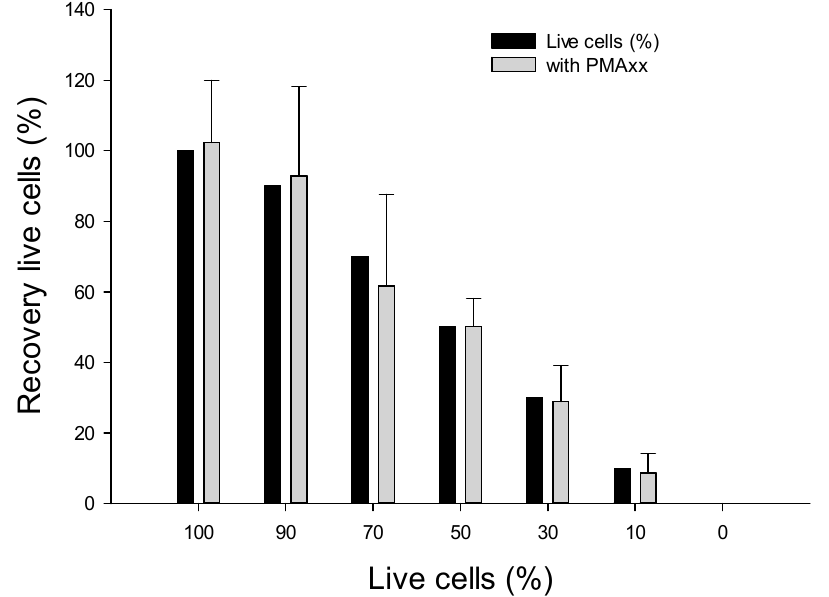
Figure 3. Effectiveness of PMAxx in selectively amplifying DNA from viable cells, mixtures of viable and dead cells were evaluated. Percentage of viable cells corresponded to 100, 90, 70, 50, 30, 10, 0%, after 10 μ M PMAxx treatment.